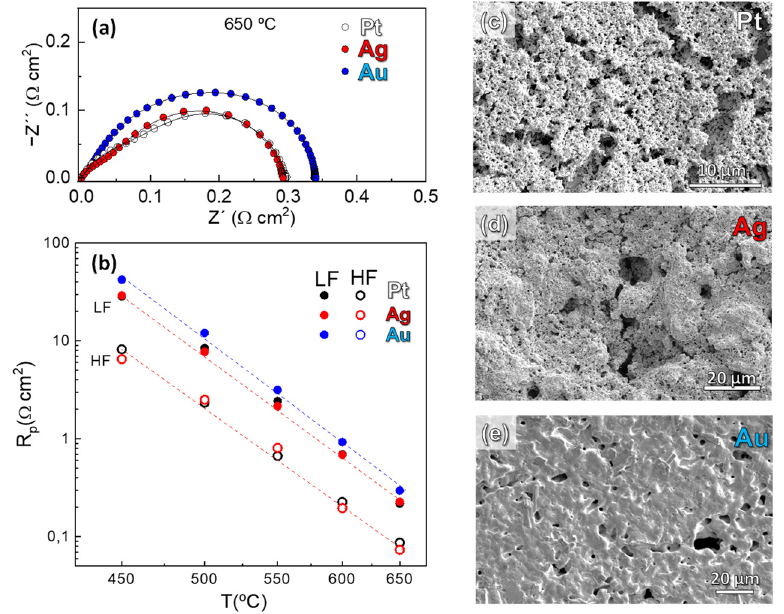
Figure 8. ( a ) Impedance spectra at 650 °C of LSCF electrodes deposited onto CGO electrolyte with Pt, Ag and Au as current collectors and ( b ) electrode resistance contributions as a function of the temperature. SEM images of the surface of ( c ) Pt, ( d ) Ag and ( e ) Au current collectors after the electrochemical tests.